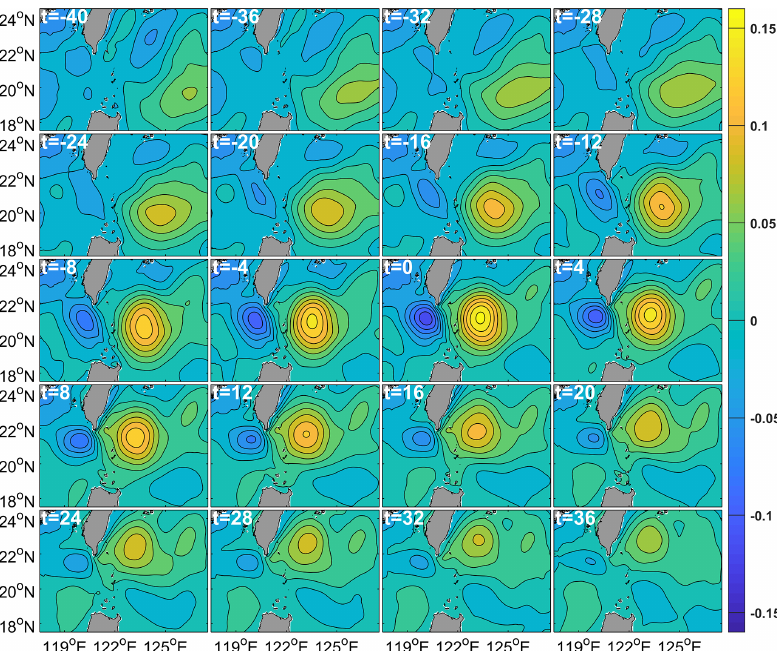
Figure 6. Evolution of AE mode of counter-rotating eddy pair in LS based on HYCOM data. Contours and shading both represent SSHA (units of m). SSHA interval is 0.02m. t value in the top left-hand corner of each panel denotes the days before (negative value) or after (positive value) AE mode of counter-rotating eddy pair reached the maximum ( t = 0). t = 0 corresponds to the time of Fig. 3b.